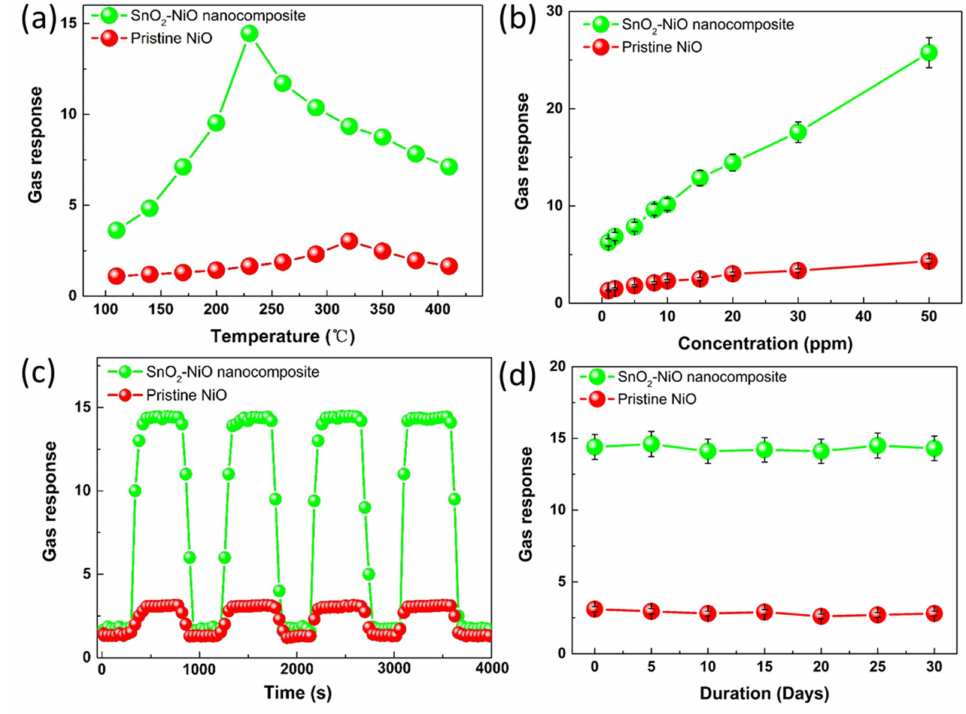
Figure 7. ( a ) The gas responses of the two samples to 20 ppm NO 2 at various working temperatures. ( b ) The gas responses of the two samples towards various concentration of NO 2 at the optimum temperature of 230 ◦ C. ( c ) The dynamic responses of the two samples at the optimum temperature of 230 ◦ C under 20 ppm NO 2 . ( d ) The stability of the two samples towards 20 ppm NO 2 at the optimum temperature of 230 ◦